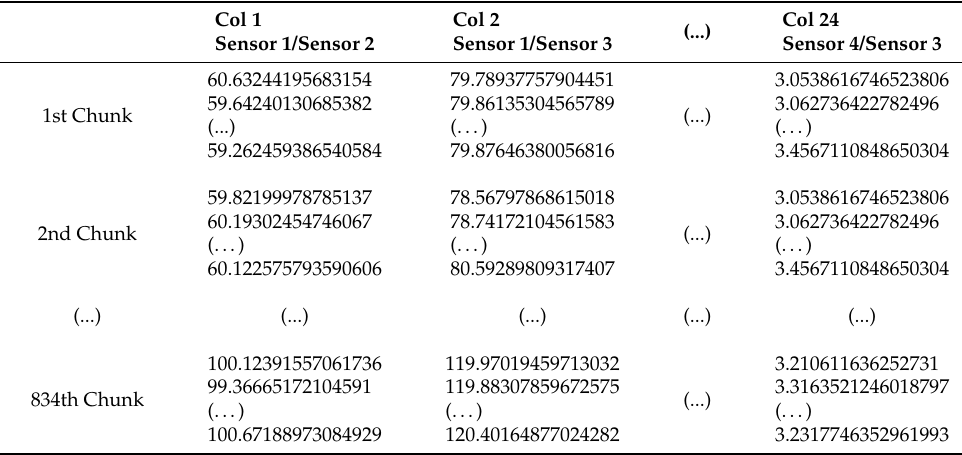
Table 1. Time windows with data subtracted and ratios between each sensor